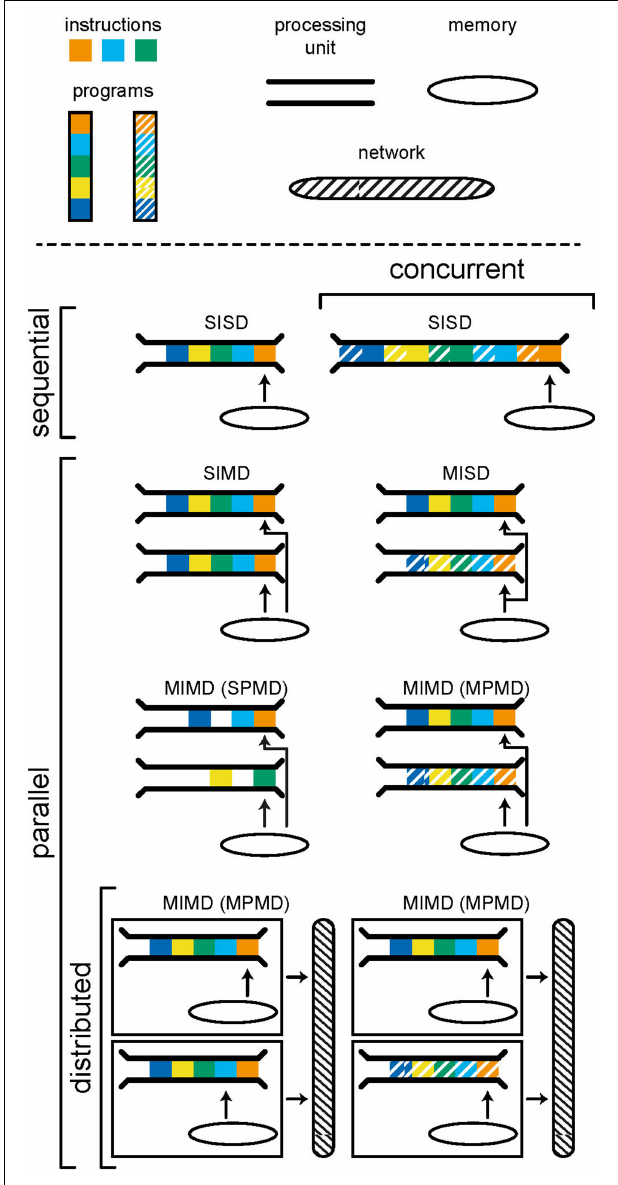
FIGURE 2 | Models of computing categorized using Flynn’s taxonomy. A program consists of a number of instructions which are executed by a processing unit. A computer, or computational unit, consists of one (sequential) or more (parallel) processing units which can access data and instructions from memory. Concurrency is achieved by interweaving instructions from different programs in order to produce the appearance of parallelism. Distributed models include separate computational units which communicate by passing messages through a network. The individual computational units in a distributed system may be sequential or